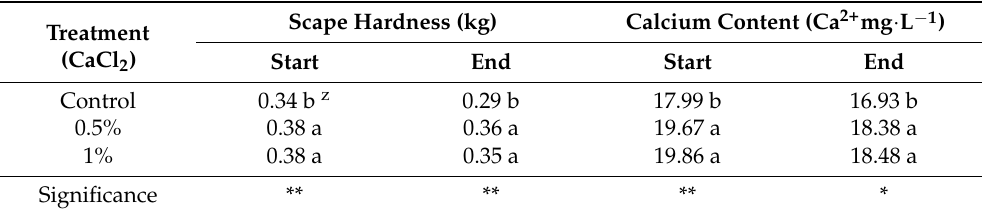
Table 2. Effects of preharvest spraying of CaCl 2 on the scape hardness and Ca 2+ content of gerbera ‘Harmony’ cut flowers at the start and end of vase